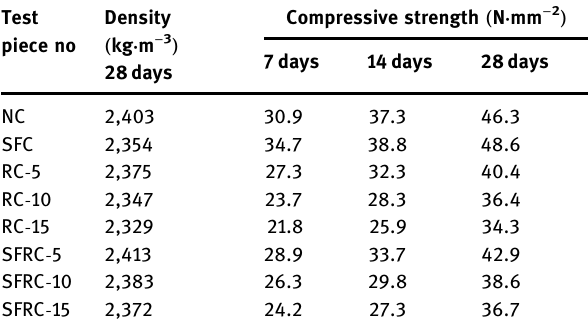
Table 2: Density and compressive strength of cube samples